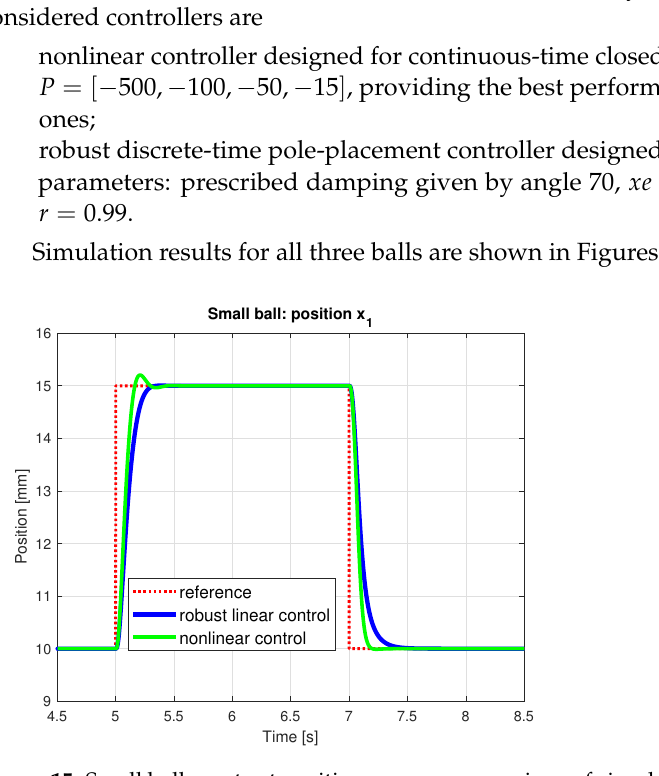
Figure 15. Small ball—output position y = x 1 : comparison of simulation results for nonlinear and robust linear pole-placement